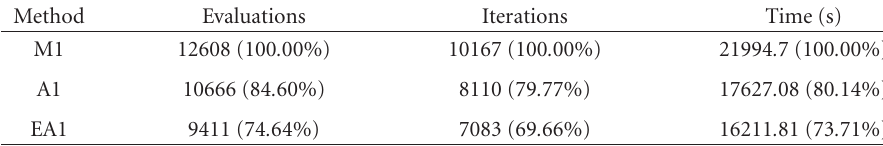
Table 4 . 5 . Results for dimensions from 81 to 100 (62